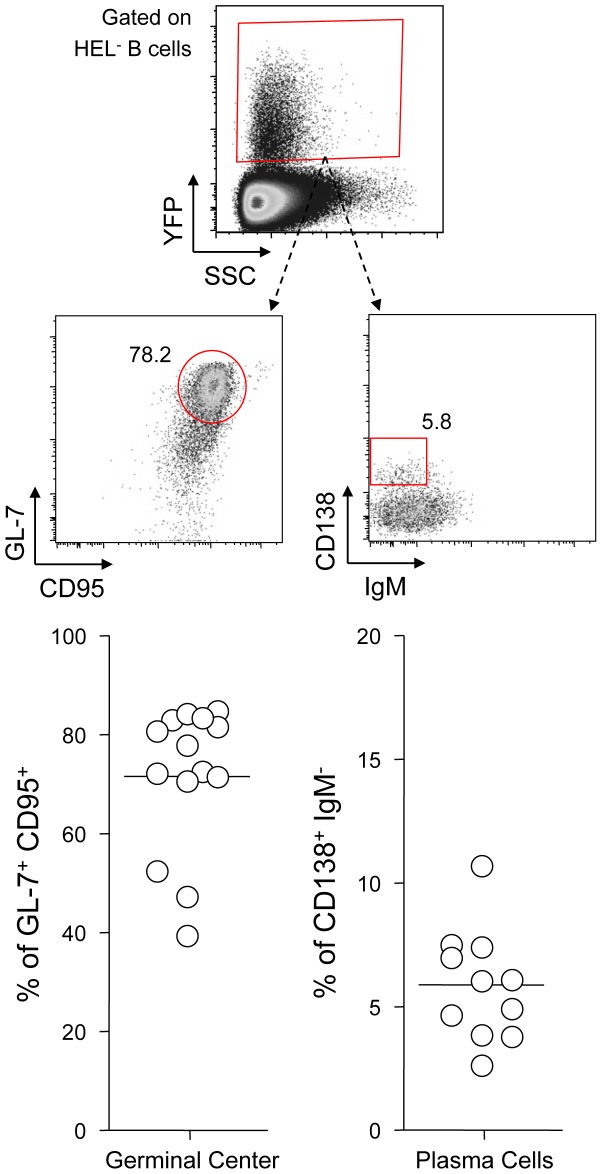
YFP+ HEL− B cells differentiate into GC and plasma cells.Splenocytes were isolated from SWHEL mice 14 dpi and analyzed by FACS. Cells were gated on the HEL− CD19+ population. On top is shown a typical phenotype of YFP+ HEL− B cells, monitoring GC (CD95+ GL-7+) and plasma cells (IgM− CD138+). Data were compiled in the graphics below; showing the percentage of GC cells (n = 14) and plasma cells (n = 11) in YFP+ HEL− B cells.